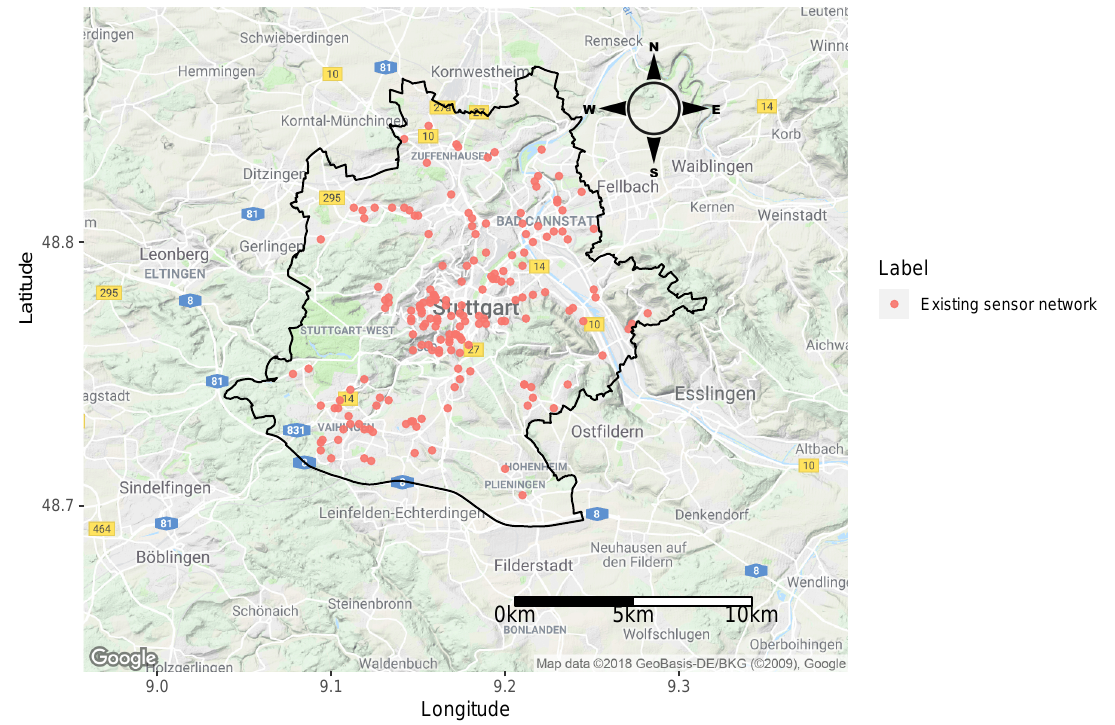
Figure 2. Study area: City of Stuttgart and the existing citizen-driven air quality network (Base map: